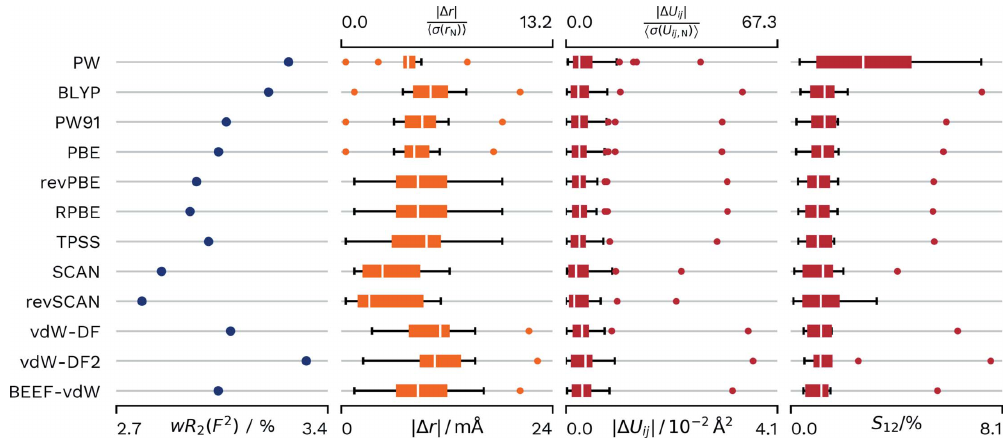
Figure 3 Differences in wR 2 ( F 2 ) and agreement with neutron values for different functionals applied to the HMa-Mg dataset. Distributions of parameters are displayed as box-whisker plots. All calculations are done at the (cid:3) point. Grid spacings: wavefunction 0.15 A˚ , density 0.075 A˚ , atomic form factor 0.0375 A˚